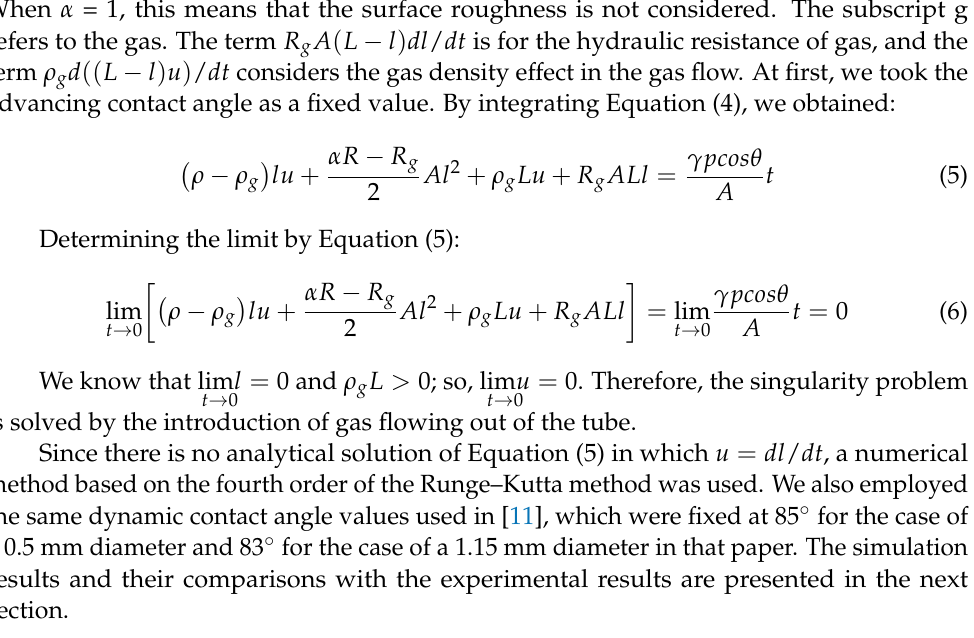
Figure 1. Liquid filling process in a circular channel. When a liquid enters the channel, the gas inside is pushed out. Table 2. Water and air properties at a lab temperature of 23 °C.